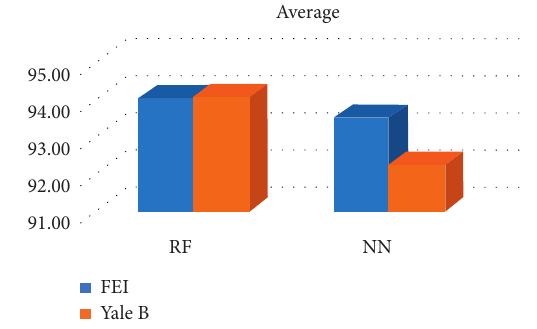
Figure 9: The average accuracy rate series of experiments on proposed methods using the FEI and Yale B datasets.